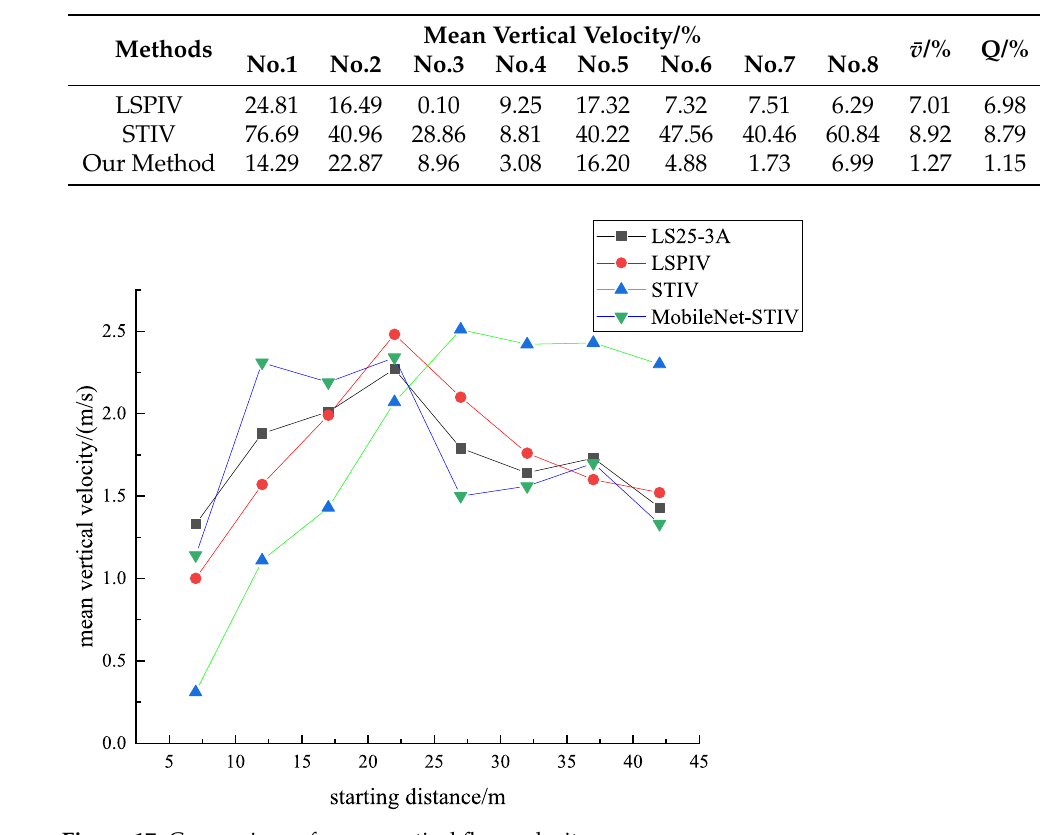
Table 9. Relative error comparison.